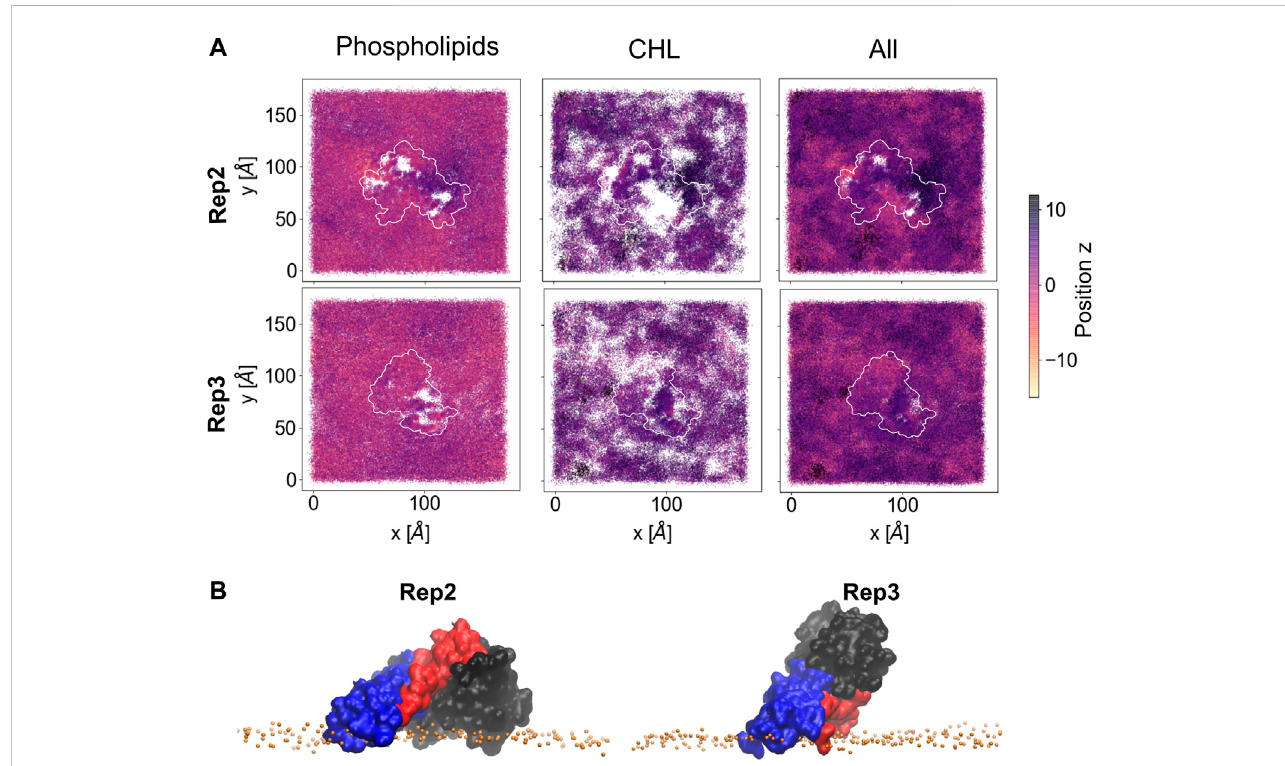
FIGURE 7 Membrane deformation due to protein binding. (A) Cumulative membrane height (z-coordinate) during the last 500 ns of simulation for Rep2 (top row) and Rep3 (bottom row). The color maps show the relative position of the lipid phosphate atoms (left), cholesterol hydroxyl group atoms (middle), and both types of atoms (right) on the binding lea fl et. The relative positions are computed with respect to their initial coordinates in the analysis period (i.e., the fi rst frame of the last 500ns of trajectory). Color intensity changes from pale yellow to dark purple as z position of atoms increase; white patches indicate absence of headgroup atoms. (B) Close up of the bound protein for Rep2 and Rep3, showing different domains inserted past the phosphate atoms in the membrane, shown as orange spheres. The 4HB is shown in blue, brace in red and PsK in black. Similar plots for Rep1 and Rep4 in Supplementary Figure